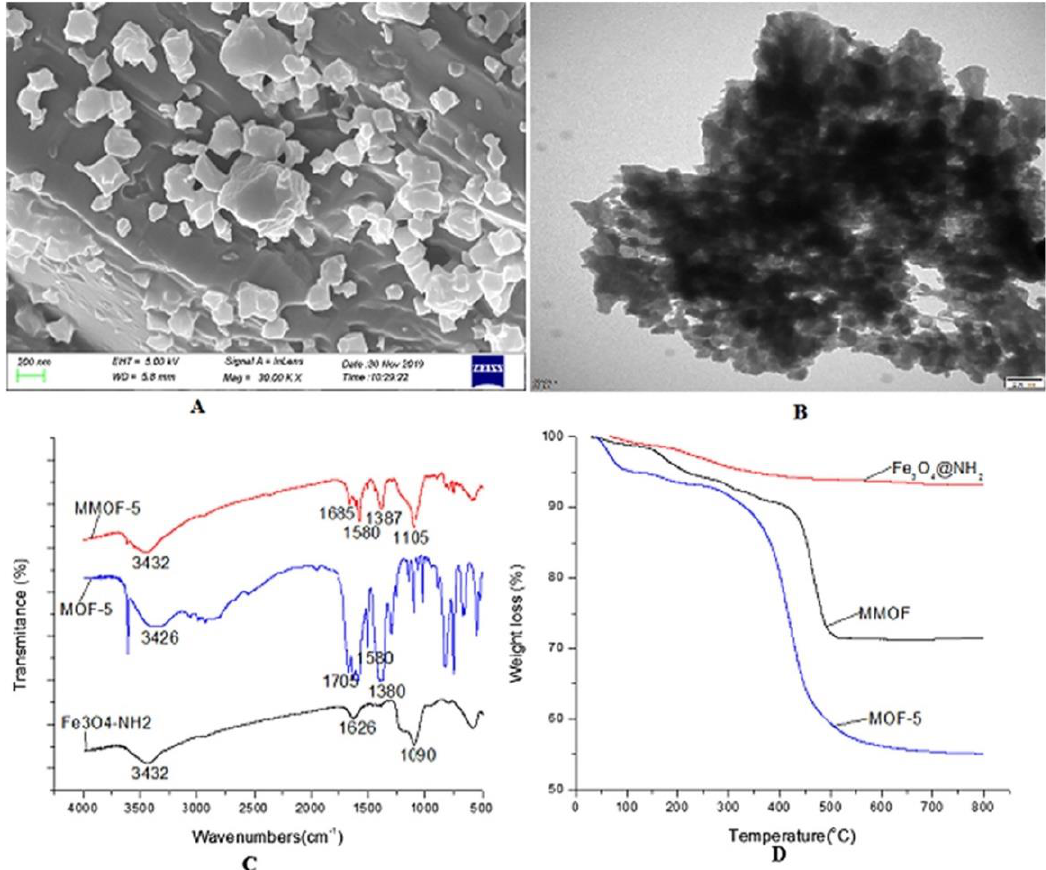
Figure 4. Example of a SEM micrograph ( A ), a TEM micrograph ( B ), an FT-IR spectrum ( C ) and a TGA curve image ( D ) of a MOF material. Reproduced with permission from [50]. Elsevier. Copyright Elsevier, 2020.